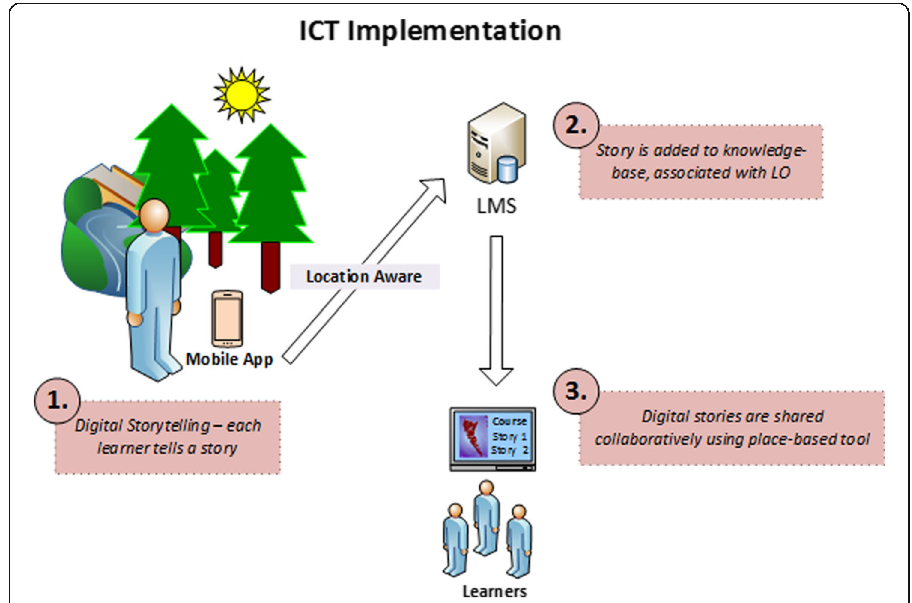
Fig. 2 Leveraging mobile technology for digital